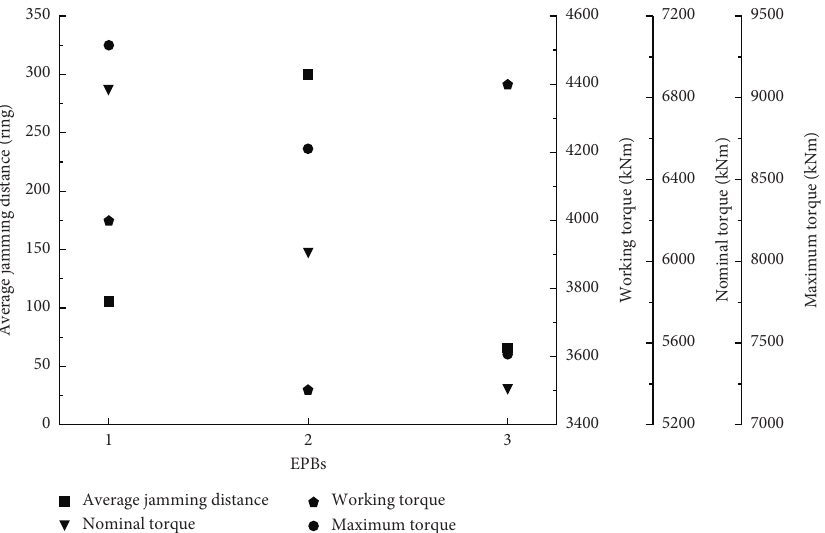
Figure 18: The comparison of the average jamming distance between the working torque, nominal torque, and maximum torque of the three